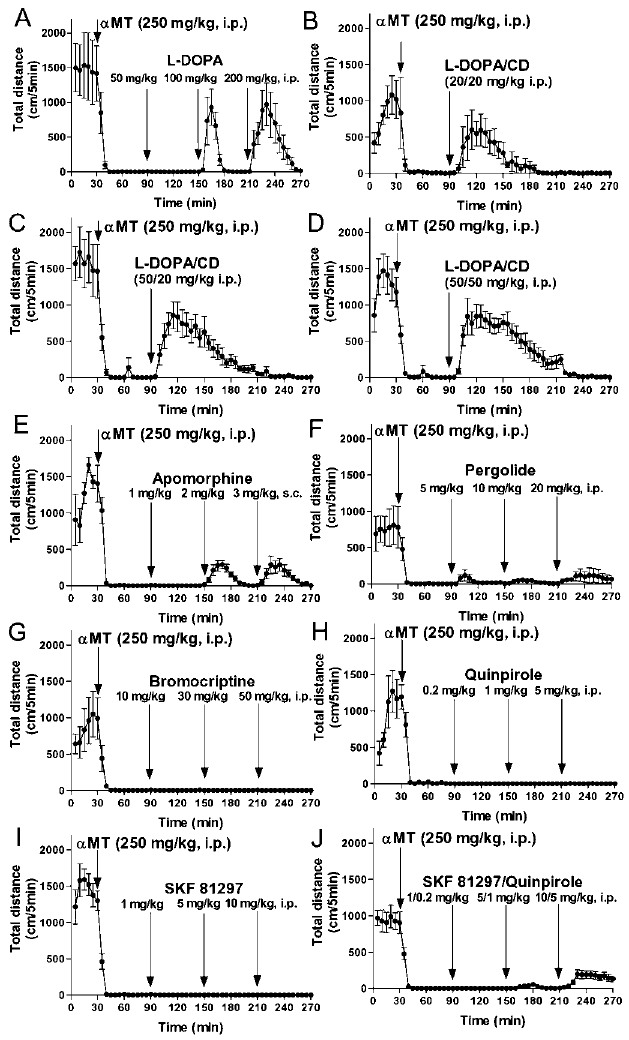
Figure 4. L-DOPA and Nonselective DA Agonists Are Effective in Restoring Locomotion in DDD Mice DAT-KO mice were placed in the locomotor activity chamber and 30 min later were treated with a MT (250 mg/kg IP) and 1 h after a MT were challenged with single or multiple doses of a drug (interval between treatments is 1 h). L-DOPA itself (A) or in combination with carbidopa (B– D) effectively restored locomotion in DDD mice, as revealed by the significant effect of L-DOPA at doses 100 and 200 mg/kg IP, or combinations of L-DOPA/carbidopa at doses 20/20, 50/20, and 50/50 mg/kg, IP (analysis of total distance traveled for 1 h after each dose of the drug; p , 0.05, two-tailed Mann-Whitney U test versus respective values in saline-treated DDD mice; data not shown). Nonselective DA receptor agonists, apomorphine (E) at doses 2 and 3 mg/kg SC, and pergolide (F) at doses 5, 10, and 20 mg/kg IP, induced locomotion in DDD mice (analysis of total distance traveled for 1 h after each dose of the drug; p , 0.05, two-tailed Mann-Whitney U test, versus respective values in saline-treated DDD mice; data not shown). D2 DA receptor agonists bromocriptine (G), quinpirole (H), and D1 DA receptor agonist ( þ )-SKF81297 (I) were not effective, but the combinations of D1 and D2 DA agonists ( þ )-SKF81297 plus quinpirole at doses 5/1 and 10/5 mg/kg IP, induced significant locomotion in DDD mice (analysis of total distance traveled for 1 h after each treatment; p , 0.05, two-tailed Mann-Whitney U test versus respective values in saline-treated DDD mice; data not shown). Experiments were performed in 6–12 mice per group. DOI: